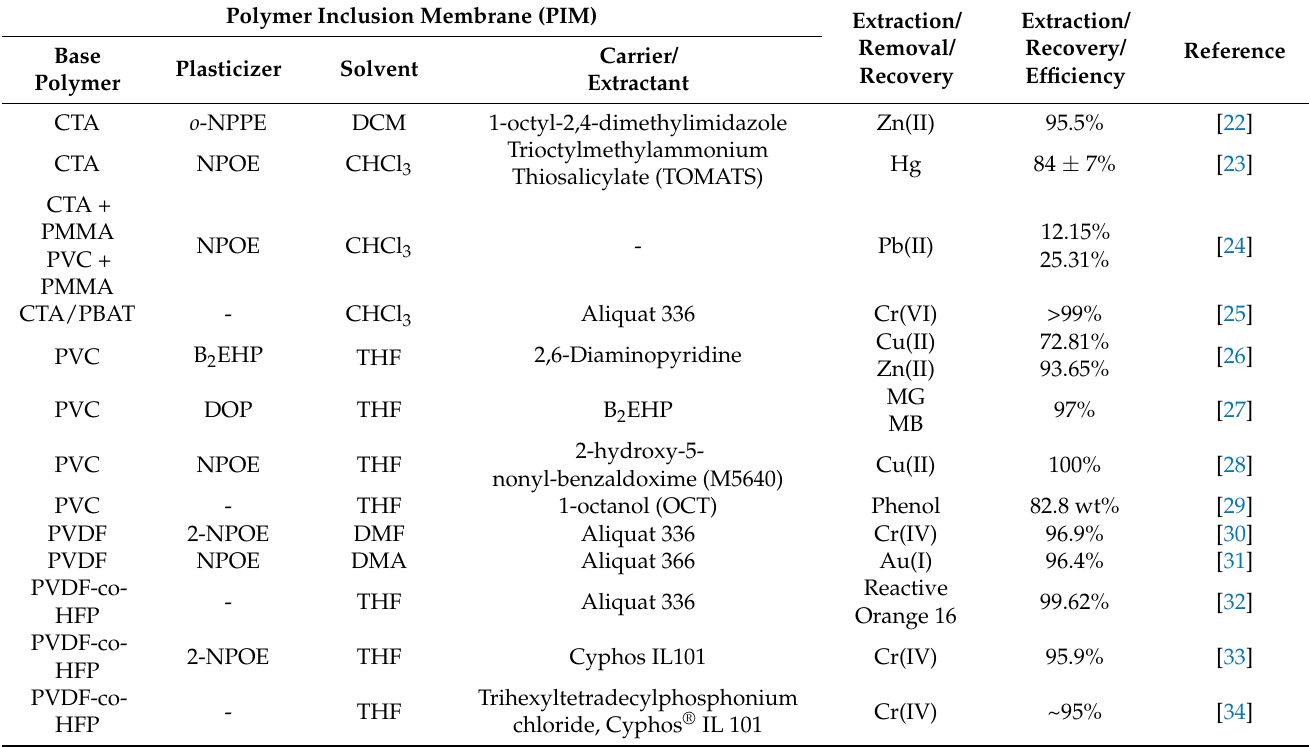
Figure 2. Chemical structure of malachite green (MG). 2.2. Fabrication of PIMs A predetermined amount of PVDF-co-HFP powder was dissolved in THF, followed by the addition of solutions containing B 2 EHP and DOP. The solution was stirred for 4 h at 400 rpm using a stirring hotplate at room temperature until a clear and homogenous solution was obtained. The membrane was cast with a membrane casting machine (thick- ness of 0.15 mm) and left to dry overnight in a fume hood at room temperature. The dried membrane was then peeled off and cut into a desired circular shape (~3.0 cm in diameter). The membrane was rinsed several times with distilled water to remove the excess solvent before further analysis was conducted. The procedure was repeated with different formu- lations of PIMs (Table 2). M1 acts as the control as it does not contain the carrier whereas M2, M3, M4, M5 and M6 signify PIMs with varying percentages of the carrier.